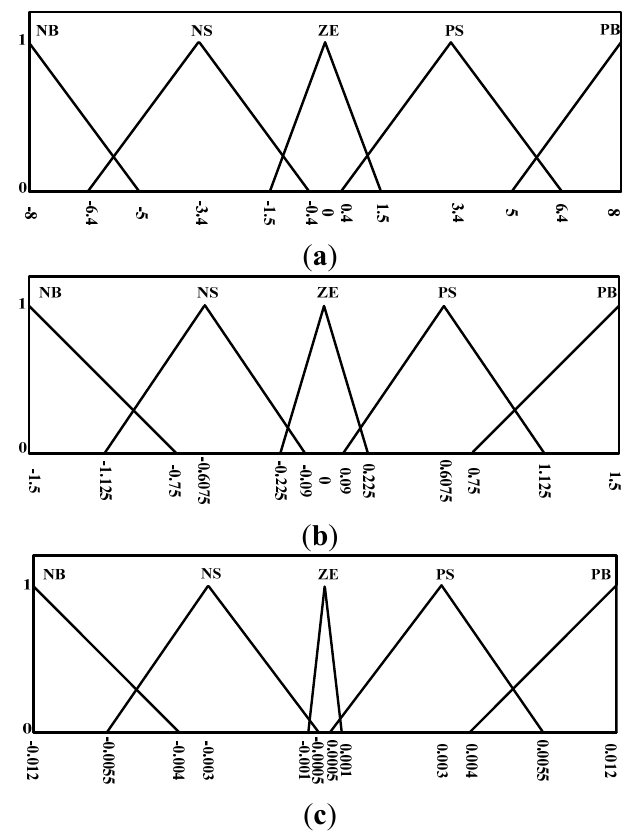
Figure 7. Membership functions for Algorithm (i): ( a ) Membership function for P-V slope, ( b ) Membership function for changes of slope; ( c ) Membership function for increment of duty ratio